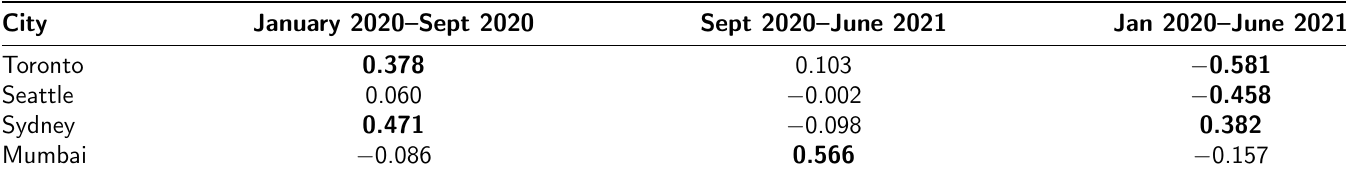
Table 1: Pearson correlation over various time periods between weekly case counts and average weekly rDD scores. Bold values are significant, with p-values ≤